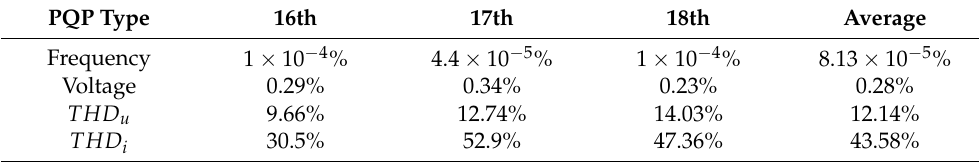
Table 8. Forecasting error MAPE (%) of 16–18 August 2021, using Interactions LR (ILR).